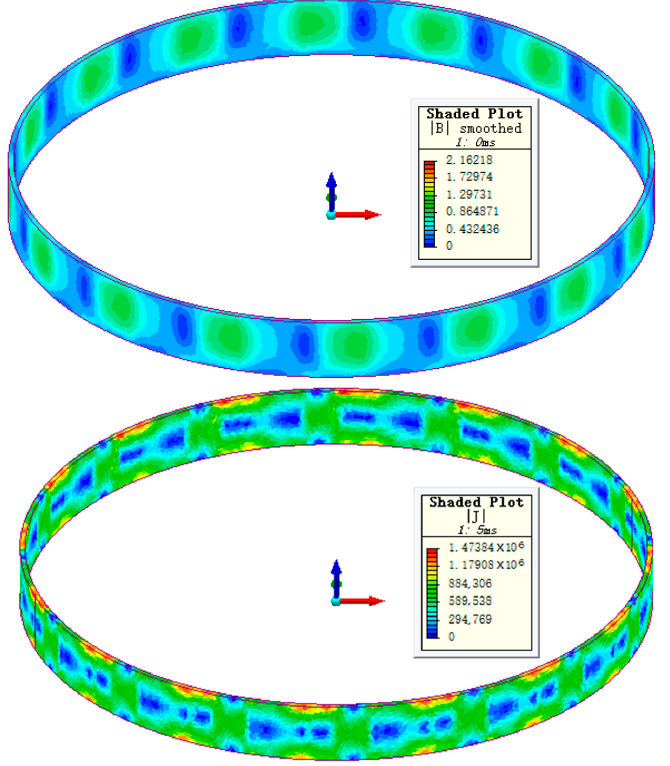
Figure 15. Flux density and eddy current distribution on isolation cover of module 1 at operating point.